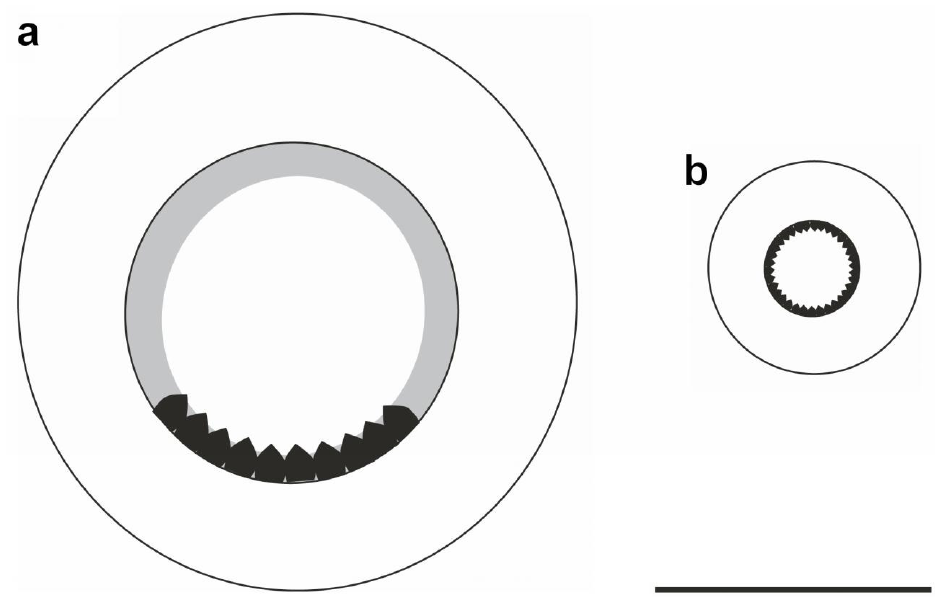
Figure 14. Schematic representation of Sepia typica arm and club suckers (SAIAB 211654, female ML 21 mm): ( a ) Sucker from third pair on left arm III; ( b ) Sucker from mid club. Scale bar 0.2 mm. In females the suckers proximal to the arm-tip series subequal in size on all arms. In most males, sucker diameter decreases gradually distally on arms I–III p., but abruptly increases for the last one to four pairs before the arm-tip series, forming a distal cluster of enlarged suckers (Figure 15a). However, in some males, suckers on arms I–III p. are subequal as in females (Figure 15b). Males with subequal (undifferentiated) suckers on arms I–III p. are more common on the East Coast than the West Coast. The unmodified right ventral arm in males (Figure 16), with the basal five to eight sucker pairs large and subequal, the next two to seven sucker pairs are abruptly smaller, followed by a distal cluster of three to six pairs of enlarged suckers before the arm-tip suckers. The hectocotylised left ventral arm (Figure 17) with the basal 40–71% (mean 58.4%) modified, bearing one proximal sucker and eight to 13 pairs of small, marginal suckers (the size decreasing gradually distally), with the ventral series smaller than, and widely separated from, the dorsal series by fleshy transverse folds. The distal portion of the arm is normal, bearing three to seven pairs of enlarged suckers, and two to eleven pairs of small to minute suckers on the arm